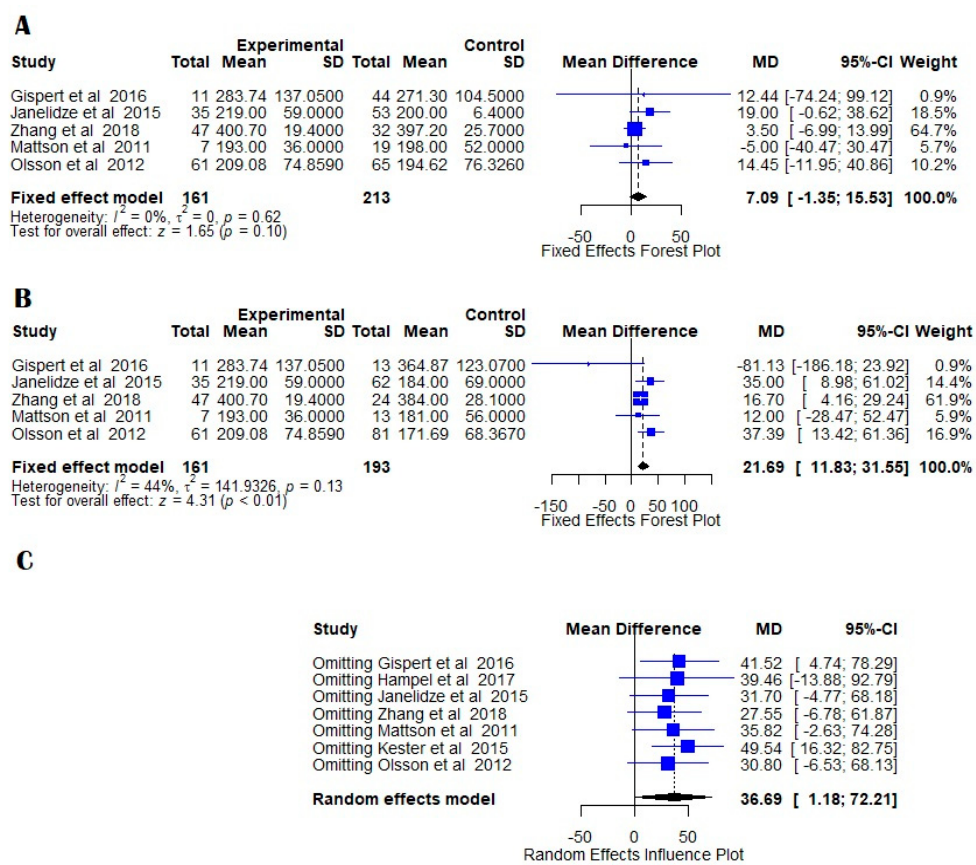
Figure 3. Forest plots of YKL-40 CSF levels in MCIAD versus NC; ( A ) and MCIAD versus MCI; ( B ) indicating decreased heterogeneity in fixed random model. The figures indicate the means, standard errors (pg/mL), 95% confidence intervals, and weighted mean differences for each study included in this meta-analysis. For each comparison, a supplemental random effects influence plot was designed to further evaluate the possible publication bias when omitting each of the included studies; ( C ) mean differences and 95% confidence intervals being calculated in each situation. The standardized mean differences between patients and controls are represented as squares whose sizes are proportional to the sample sizes. The whiskers represent the 95% confidence intervals. The diamonds represent the pooled estimate based on the random-effect model with the center representing the point estimate and the width indicating the assessed 95% confidence interval. The heterogeneity indicators (I 2 , τ 2 , p ) are presented below each random effects Forest